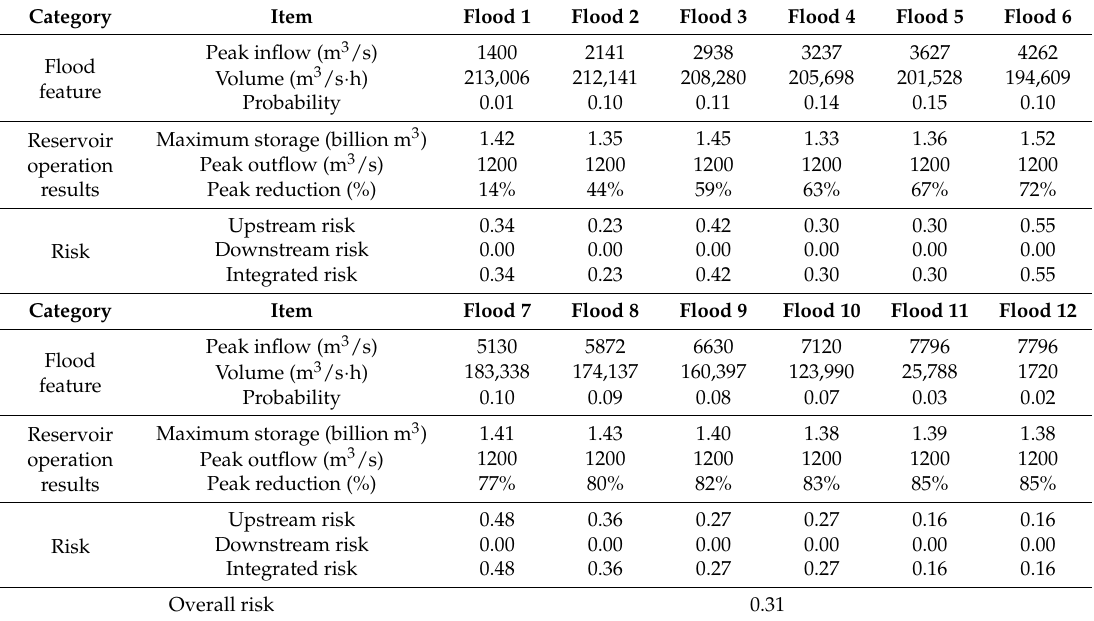
Table 5. Risk results of the Meishan reservoir for the “And” scenario.